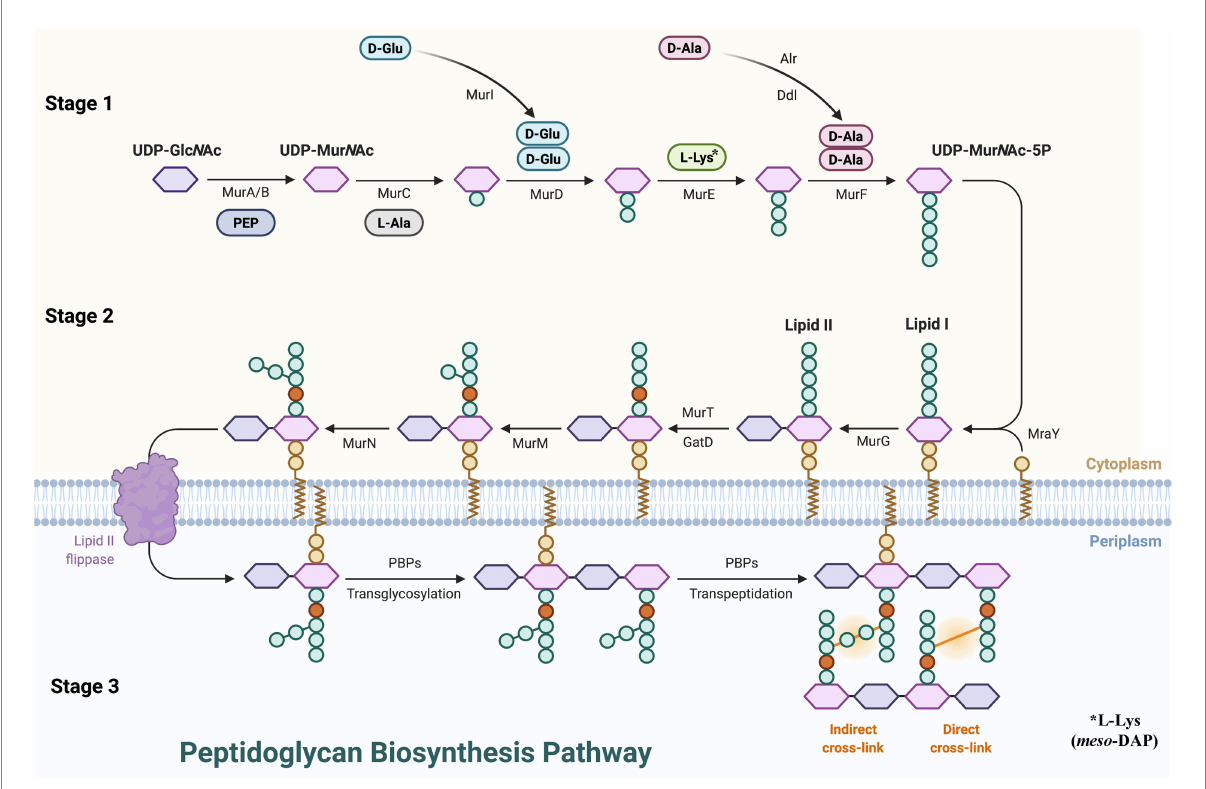
FIGURE 1 Peptidoglycan biosynthesis pathway. UDP-GlcNAc, uridine diphosphate N-acetylglucosamine; PEP, phosphoenol pyruvate; MurA, UDP-GlcNAc enol pyruvate transferase; MurB, UDP-N-acetyl allylacetone glucosamine reductase; MurG, decadecenyl diphosphate-MurNAc-pentapeptide- UDP-GlcNAcGlcNAc transferase; MraY, UDP-MurNAc-pentapeptide phosphotransferase; PBP, penicillin-binding